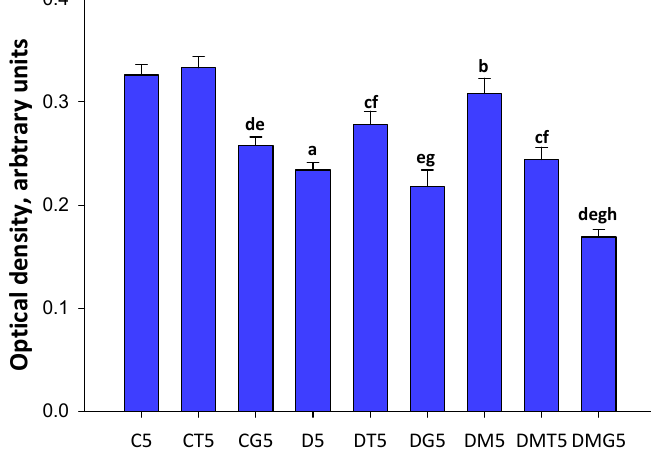
Figure 8. The optical density for LH/hCG-R immunostaining in the testis of control and diabetic rats, and the effect of metformin and LH/hCG-R-agonists treatment. a —the difference between the C5 vs. D5; b —the difference between the D5 vs. DM5; c —the difference between the D5 vs. DT5 and DM5 vs. DMT5; d —the difference between the C5 vs. CG5 and DM5 vs. DMG5; e —the difference between the CT5 vs. CG5, DT5 vs. DG5 and DMT5 vs. DMG5; f —the difference between the CT5 vs. DT5 or DMT5; g —the difference between the CG5 vs. DG5 or DMG5; and h —the difference between the DG5 vs. DMG5 are significant at p < 0.05. The data are presented as the M ± SEM, n = 5 (10 measurements in each